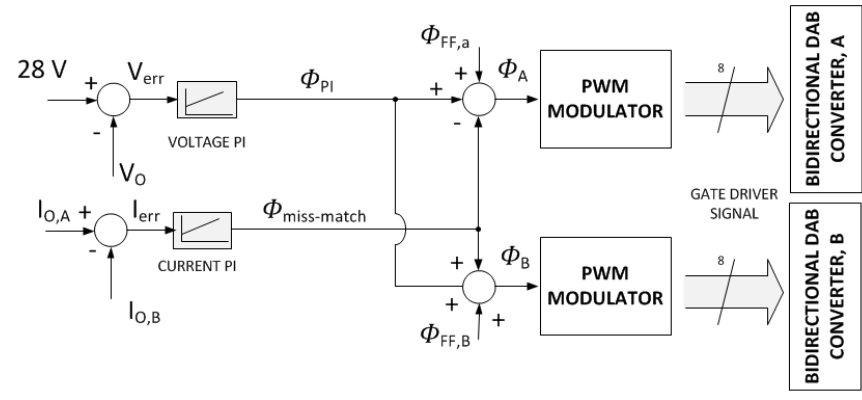
Figure 15. Structure of closed-loop system for parallel operation with current compensator.